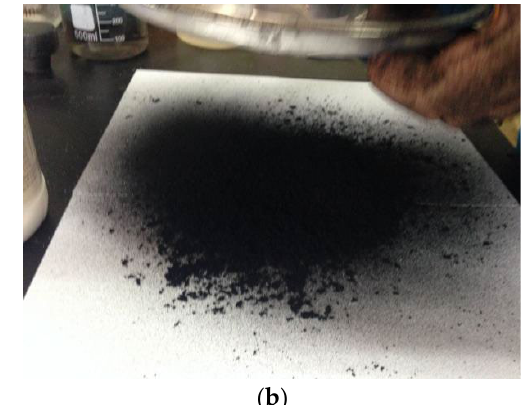
Figure 1. Synthetic reaction principle and expansion diagram of water swellable rubber.